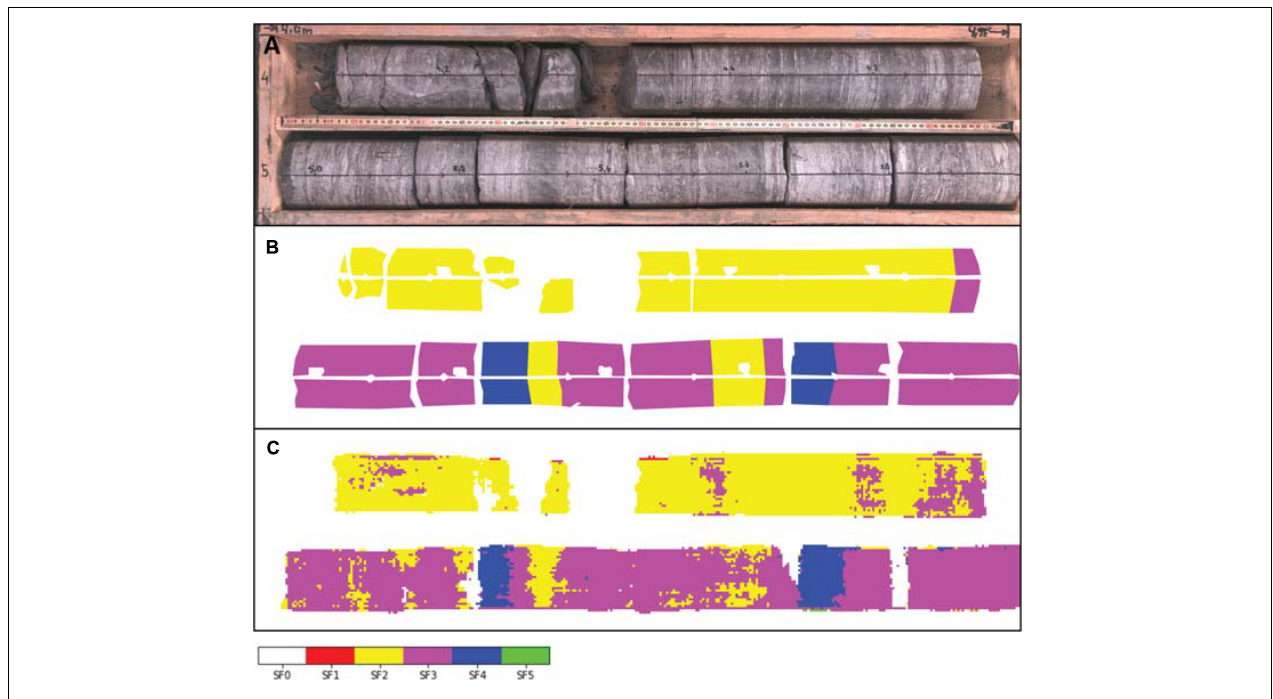
FIGURE 3 | Example of a 2 m drill core interval from BAD-2 (depth meter 4.00 to 6.00), and test of the predictive mode of the trained DCNN (ResNet-50). (A) Original input image. (B) Same image with manual assignment of subfacies types (ground truth). (C) Automated prediction of the trained DCNN (1728 sub-images; see Rempfer et al., in review). Color labels display the distinct subfacies classes. SF0 represent parts of the original image that are not identified as a subfacies type (e.g., depth labeling, broken core sections and wooden storage